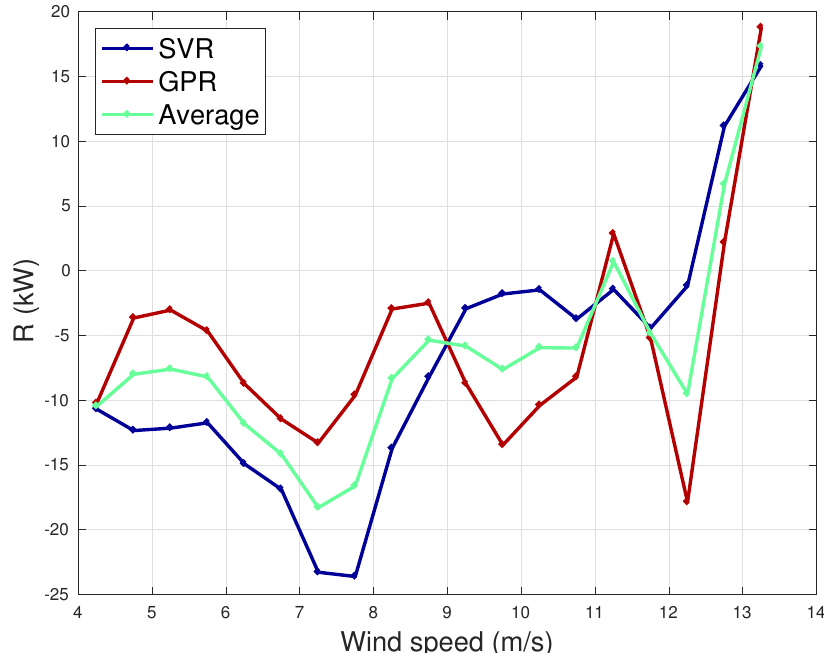
Figure 4. Residuals of the SVR and GPR, averaged per wind speed bins of 0.5